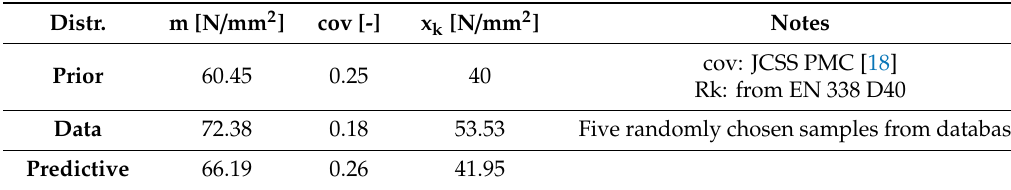
Table 5. Exemplary Bayes updating of bending strength based on an oak samples–prior model from the Probabilistic Model Code (PMC).